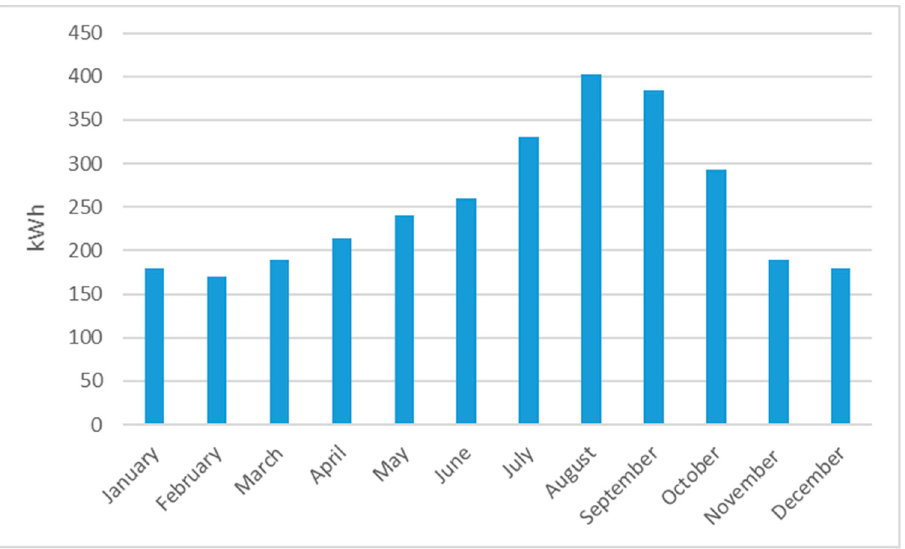
Figure 2. Electric energy load.